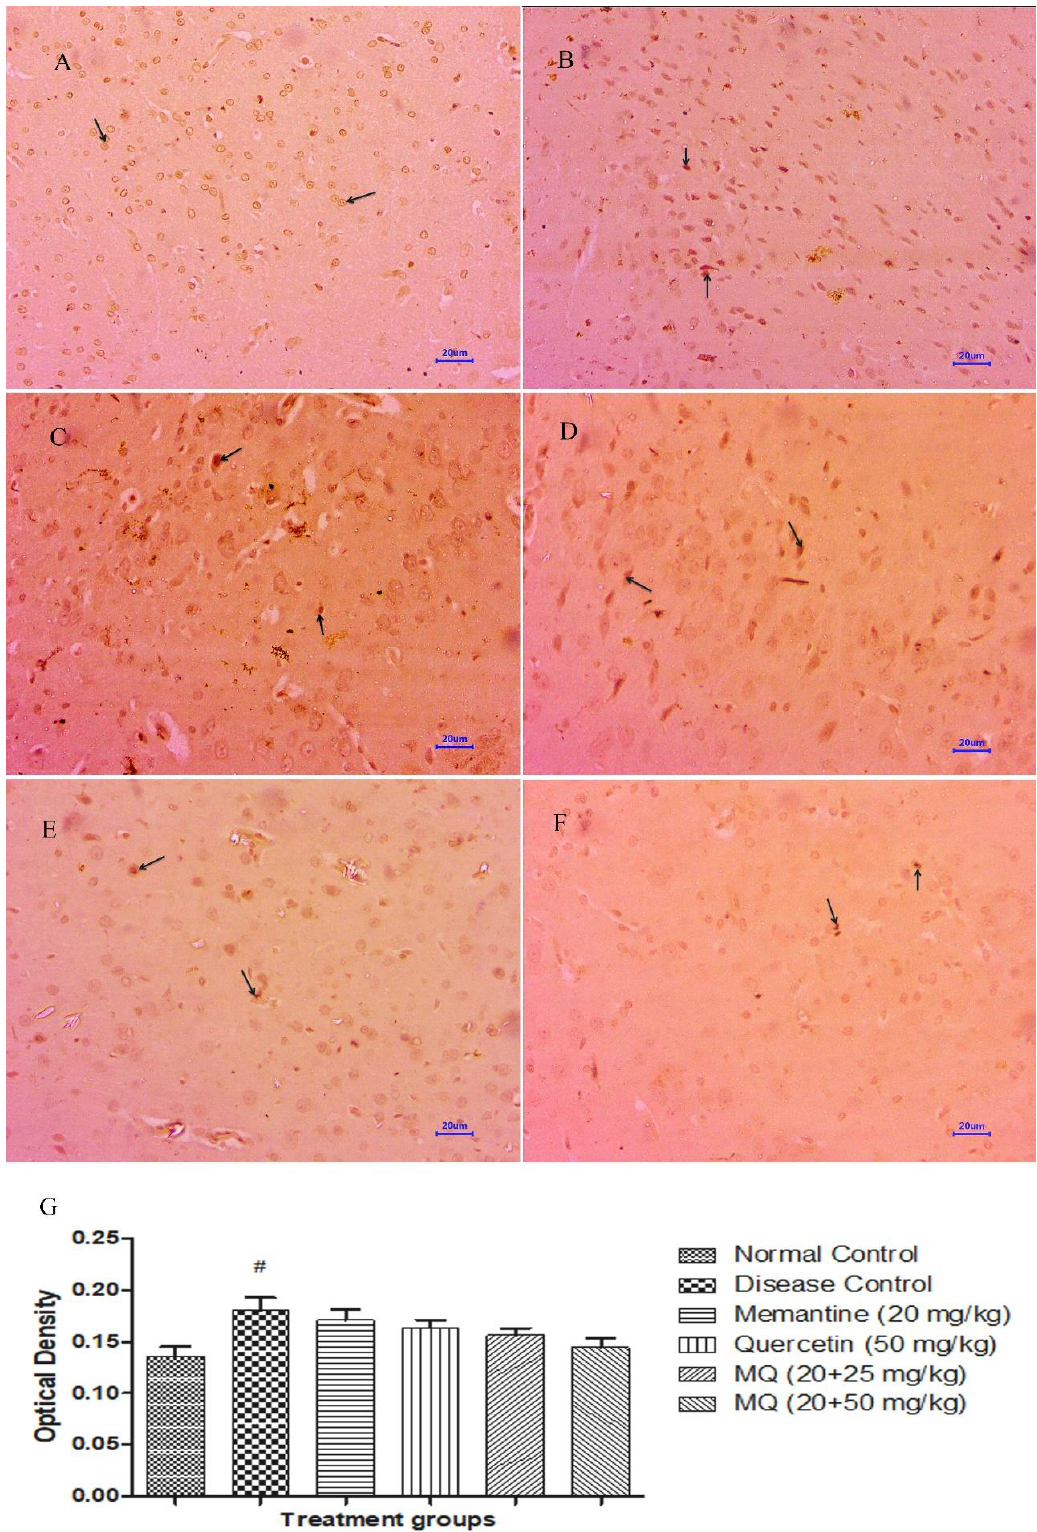
Figure 11. Effect of quercetin and quercetin administered with memantine on immuno-histochemical-stained cortex (400×). ( A ): Normal control, ( B ): Disease control, ( C ): Memantine (20 mg/kg), ( D ): Quercetin (50 mg/kg), ( E ): Memantine + quercetin (20 + 25 mg/kg), ( F ): Memantine + quercetin (20 + 50 mg/kg), ( G ): Optical density data. Data expressed as mean±SEM (n = 3), # p < 0.05 when compared with normal control.